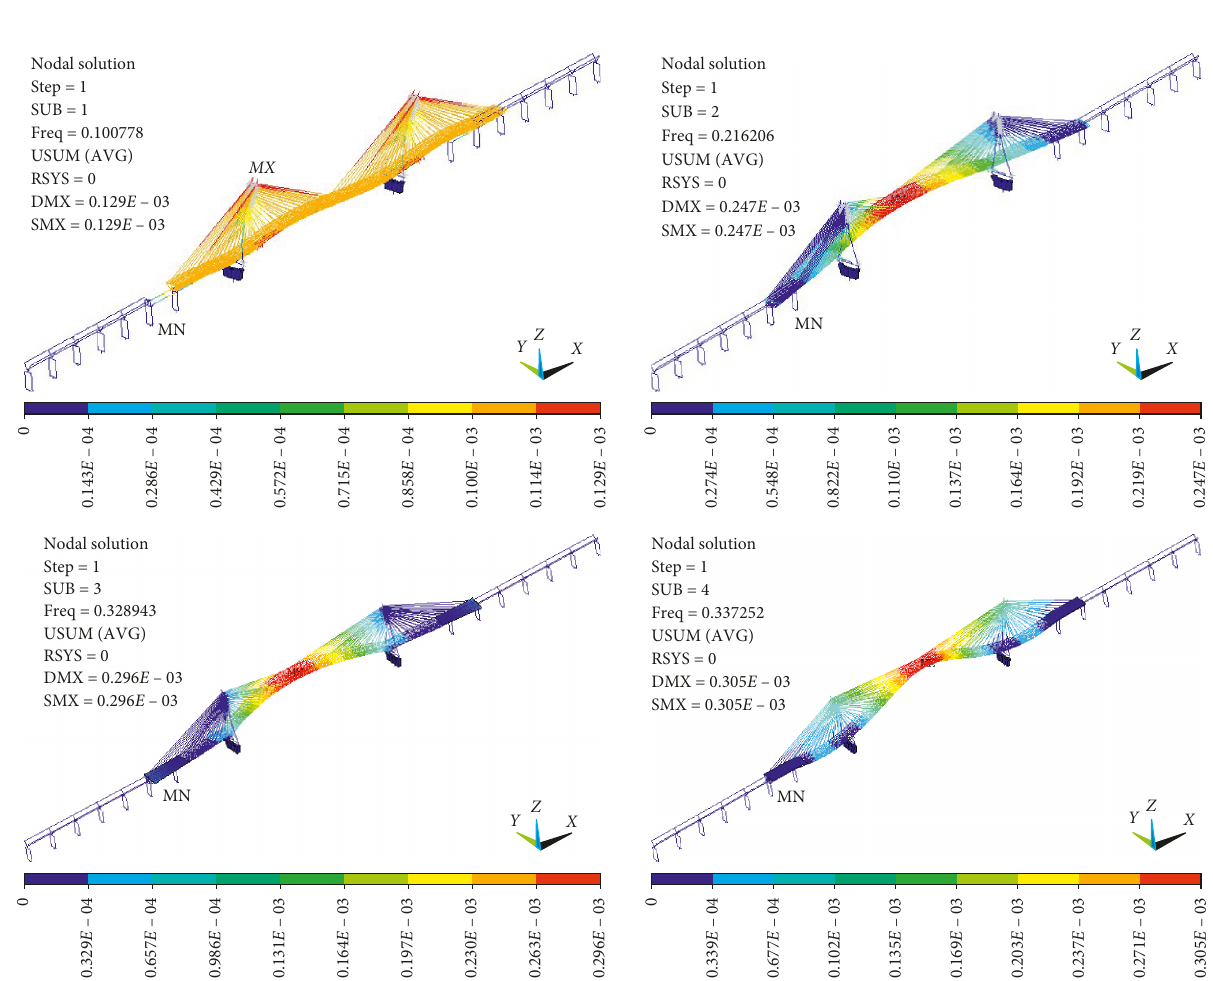
Figure 6: Mode shapes of Niutianyang Bridge. (a) Mode 1. (b) Mode 2. (c) Mode 3. (d) Mode